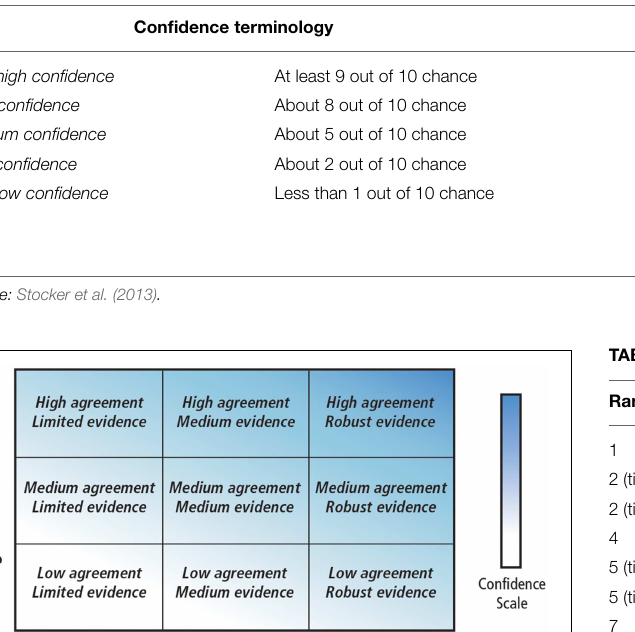
TABLE 1 | Breakdown of the IPCC AR5 confidence and likelihood terminology.